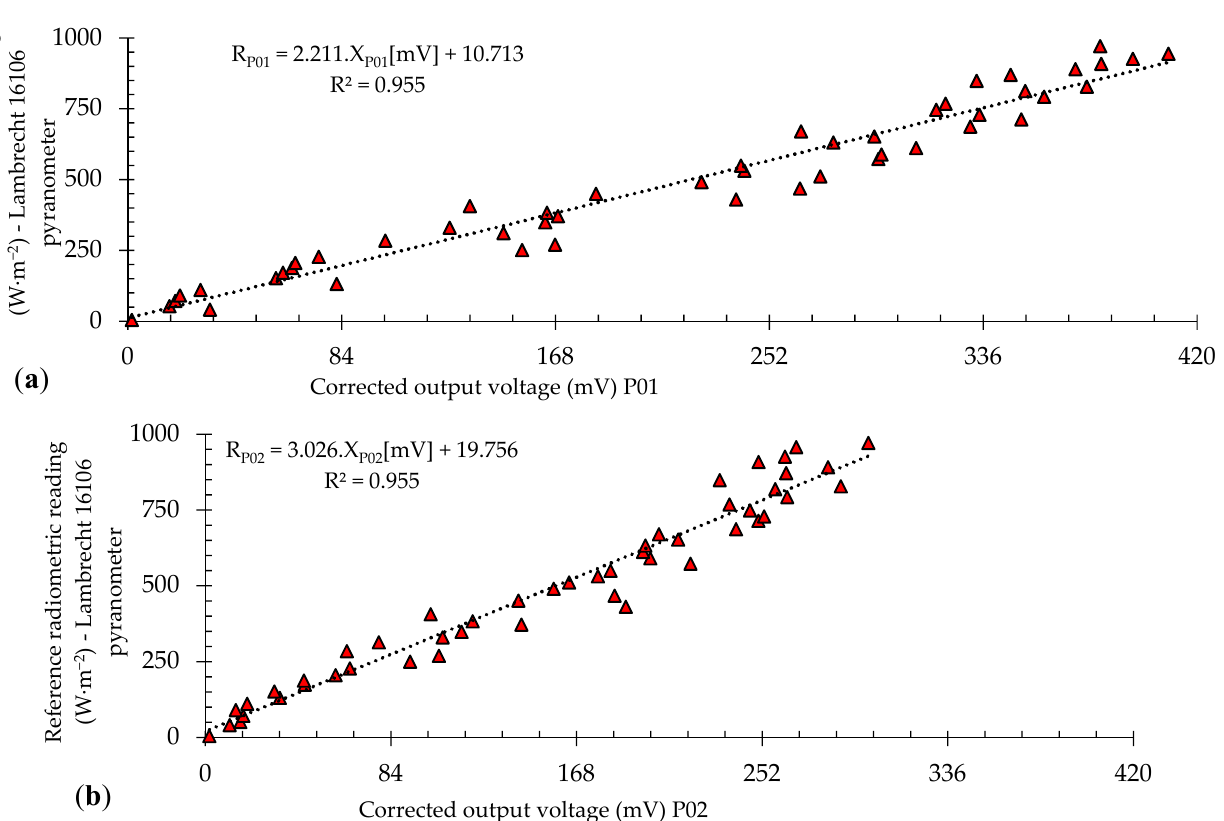
Figure 11. Solar irradiation by the reference pyranometer vs. the prototype response: ( a ) P01, ( b ) P02.